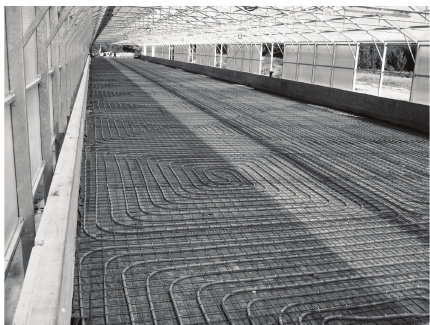
Figure 2: Heating floor system in drying hall.